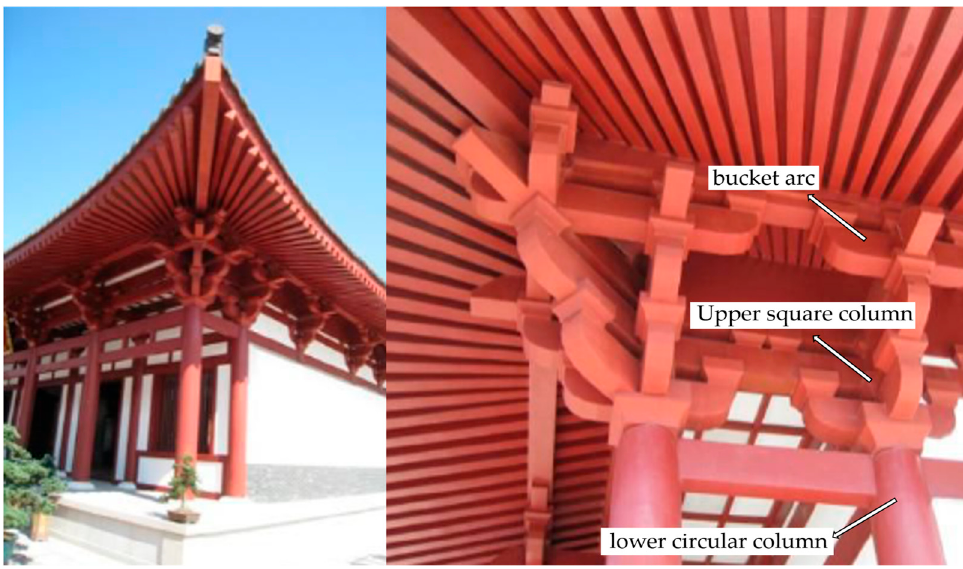
Figure 1. Photo of bucket arc and connection of upper and lower column.